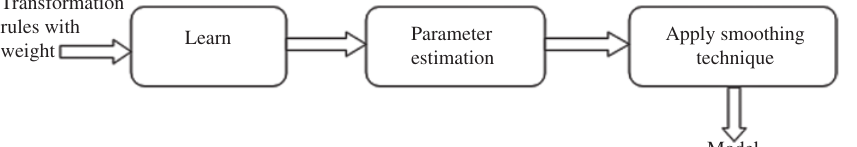
Figure 6: Learning